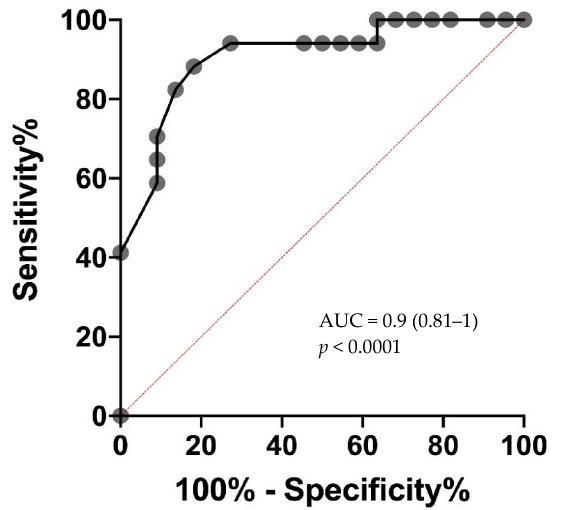
Figure 4. Receiver operating characteristic (ROC) curve of eosinophil count showing specificity and sensitivity for COVID-19 diagnosis. AUC, area under the ROC curve. Table 4. Diagnostic performance for eosinopenia and RT-PCR the day of suspicion.